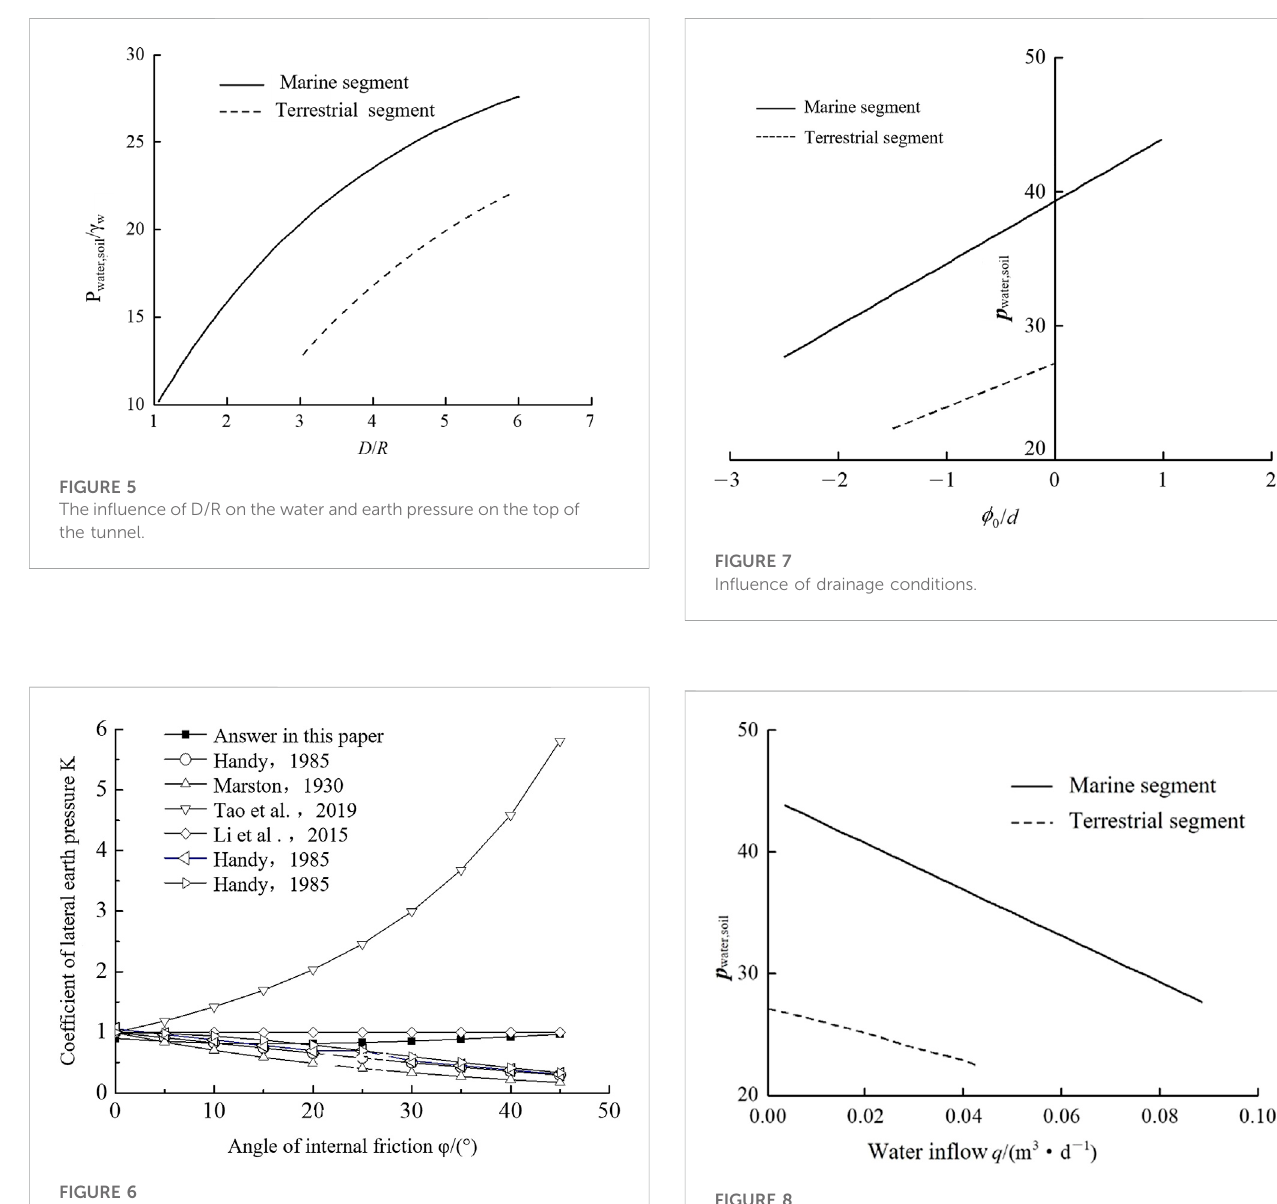
FIGURE 8 In fl uence of water in fl